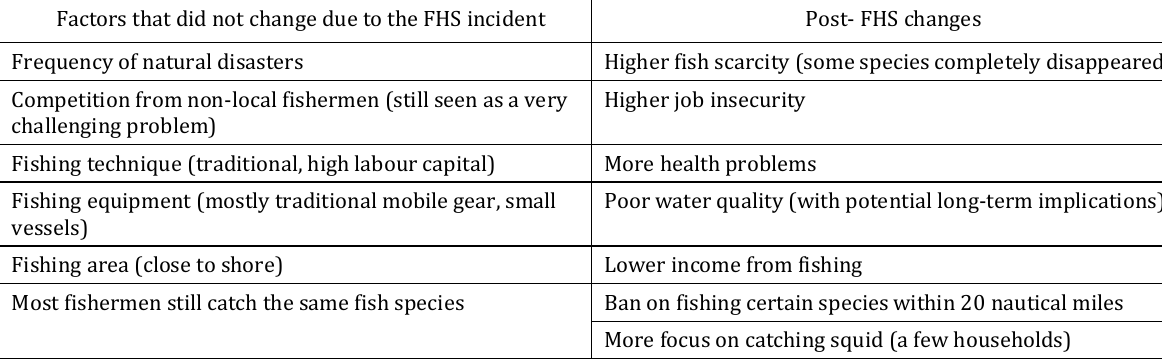
Table 3. Perceptions of households regarding the changes of livelihood resources and